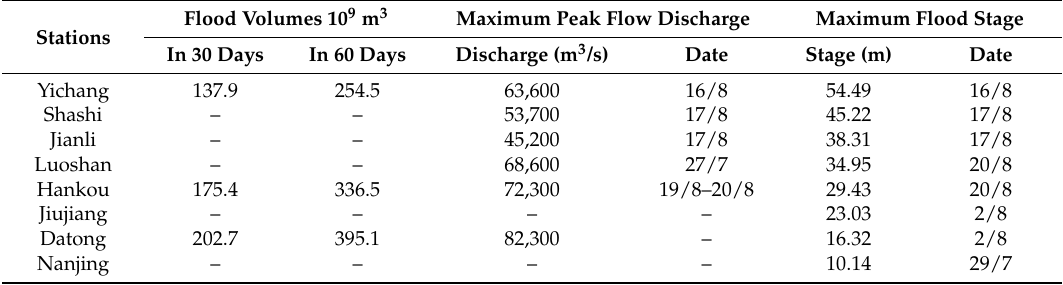
Table 7. Characteristics of major floods in China in 1998 (Data adapted from Zhou and Chen [41]).